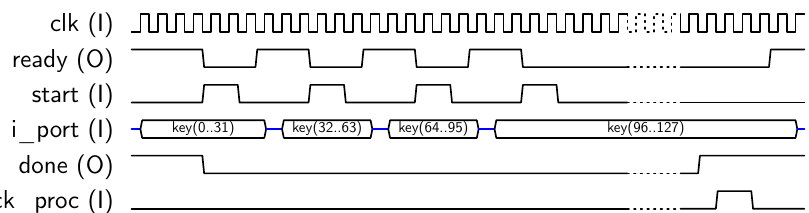
Figure 5. Sequence for AES-128 key input.